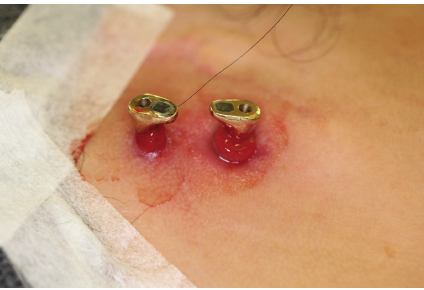
Figure 3: Persistent adverse periabutment skin response around the gold alloy